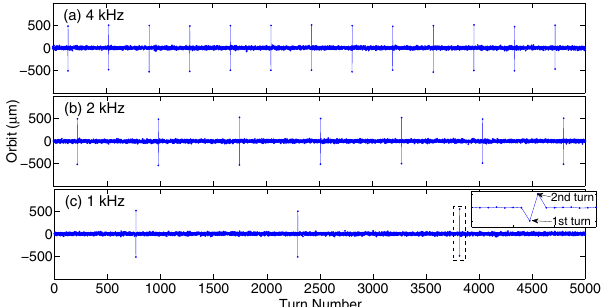
FIG. 8. TbT BPM signal at beam line 3.1 for different KAC frequency (a) 4 kHz, (b) 2 kHz, and (c) 1 kHz. The inserted in (c) shows the magnified beam orbit around one KAC pulse.